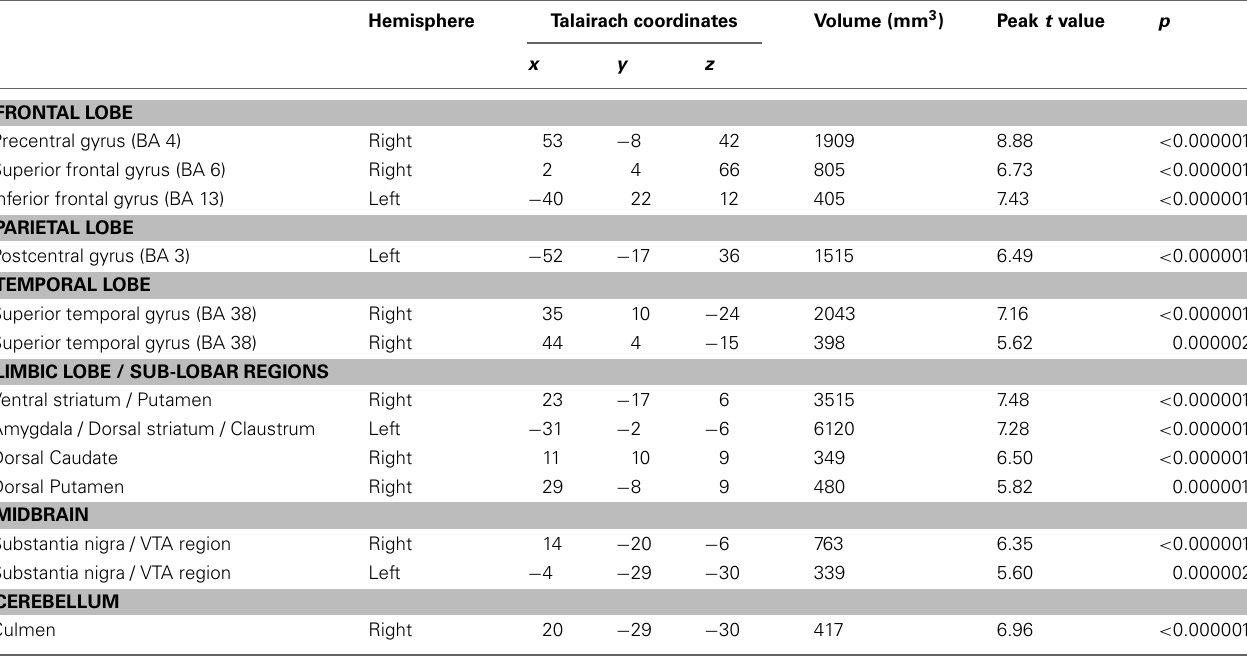
Table 4 | Areas of significant activation from Own Happy > Unknown Happy contrast in whole brain analyses. Hemisphere Talairach